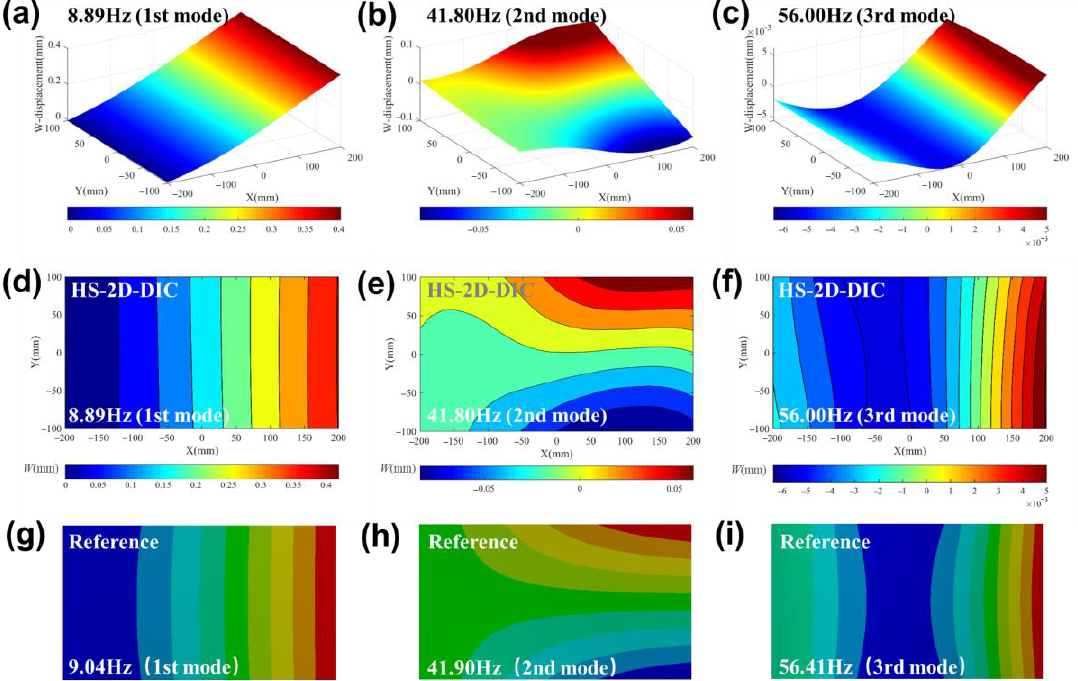
Figure 12. The three-dimensional mode shapes of the rectangular cantilever panel estimated at natural frequencies by HC-2D-DIC of ( a ) 8.89 Hz, ( b ) 41.80 Hz, ( c ) 56.00 Hz; the two-dimensional mode shapes of the rectangular cantilever panel estimated at the natural frequencies by HC-2D-DIC of ( d ) 8.89 Hz, ( e ) 41.80 Hz, ( f ) 56.00 Hz; and the mode shapes of the rectangular cantilever panel estimated at the natural frequencies by FEA of ( g ) 8.89 Hz, ( h ) 41.80 Hz, ( i ) 56.00 Hz.